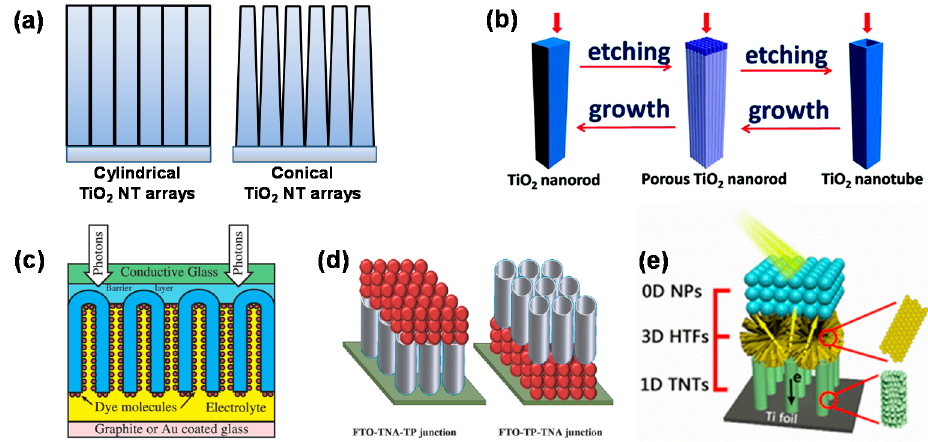
Figure 12. Schematic diagrams on the photoanode architectures in the 1D TiO 2 nanostructure-applied DSSCs. ( a ) Cylindrical- and conical-shaped TiO 2 NT arrays; ( b ) porous rutile TiO 2 NR arrays by the post-etching process. Reprinted with permission from [53]. Copyright 2012 American Chemical Society; ( c ) Frontside-illuminated TiO 2 NT-DSCs using Ti metal-deposited TCO substrates. Reprinted with permission from [50]. Copyright 2006 American Chemical Society; ( d ) Hierarchical layer-by-layer photoanode incorporating TiO 2 NT array and TiO 2 NP layer. Reprinted with permission from [51]. Copyright 2011 American Chemical Society; ( e ) Hierarchical structured photoanode incorporating branched TiO 2 NT arrays and TiO 2 hollow microspheres. Reprinted with permission from [52]. Copyright 2014 American Chemical Society.